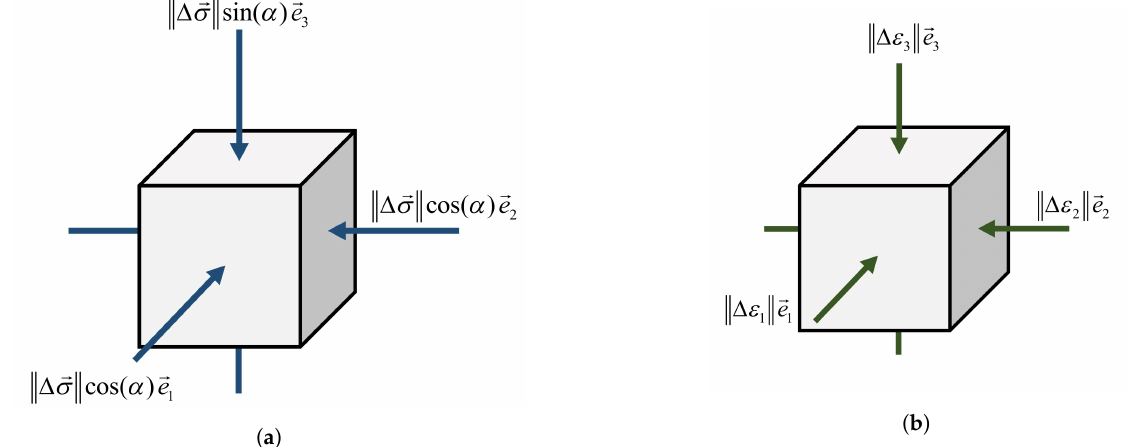
Figure 14. ( a ) The stress probe is applied on the specimens, ( b ) the strain response of the specimens is calculated by DEM.